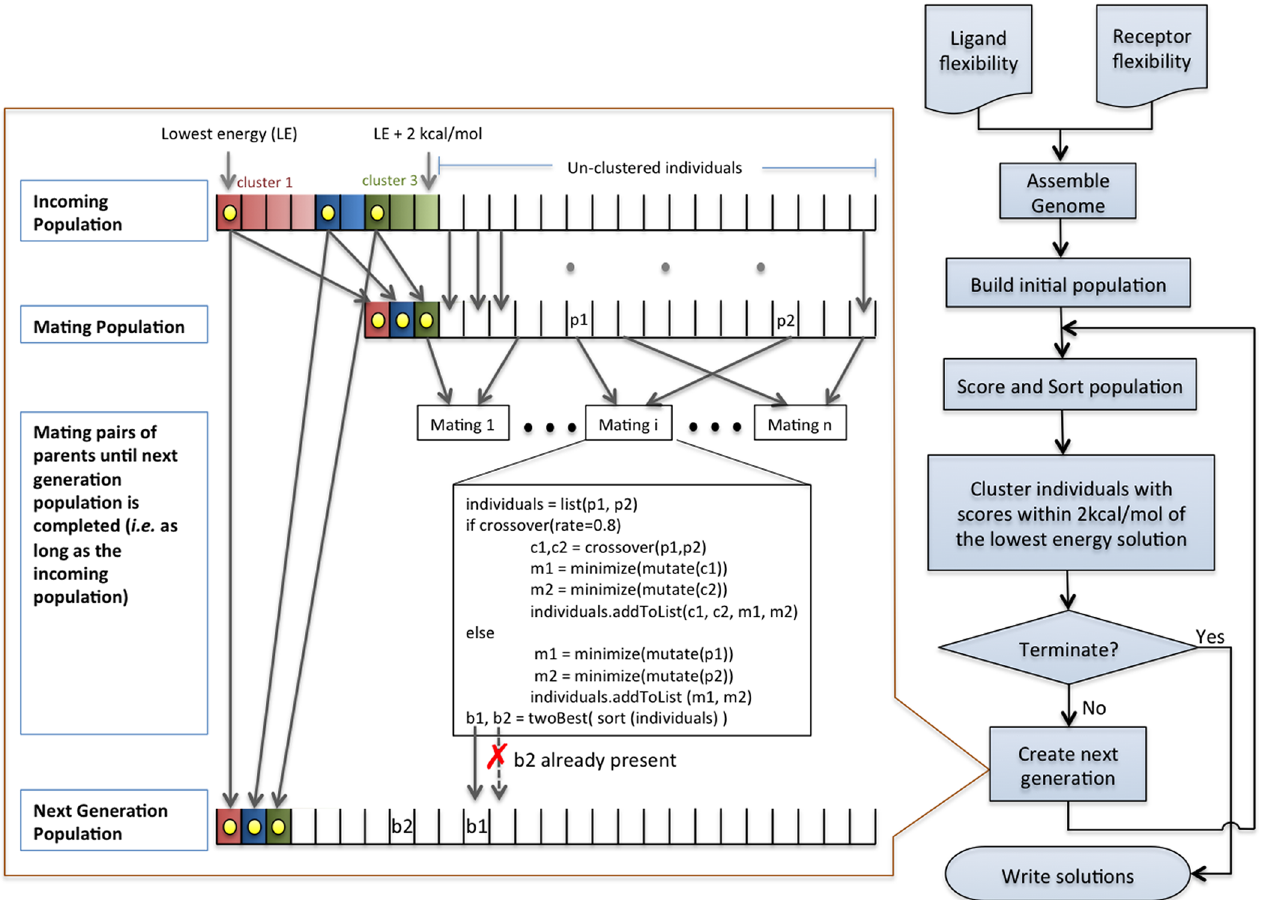
Fig 3. Overall flowchart of ADFR. The flexibility information of the ligand (i.e. rotatable bonds) and receptor (i.e. flexible side-chains) is used to assemble the genome from which an initial list of solutions (i.e. population) is created. The population is scored, sorted, and top-ranking solutions are clustered. The GA seeds the next generation with the best solution of each cluster and completes it by crossing-over, mutating, and minimizing individuals from the mating population. The optimization stops when one of the termination criteria (maximum number of generations or evaluations) is reached or the search converges, at which point the solutions within 1 kcal/mol of the best solution are written